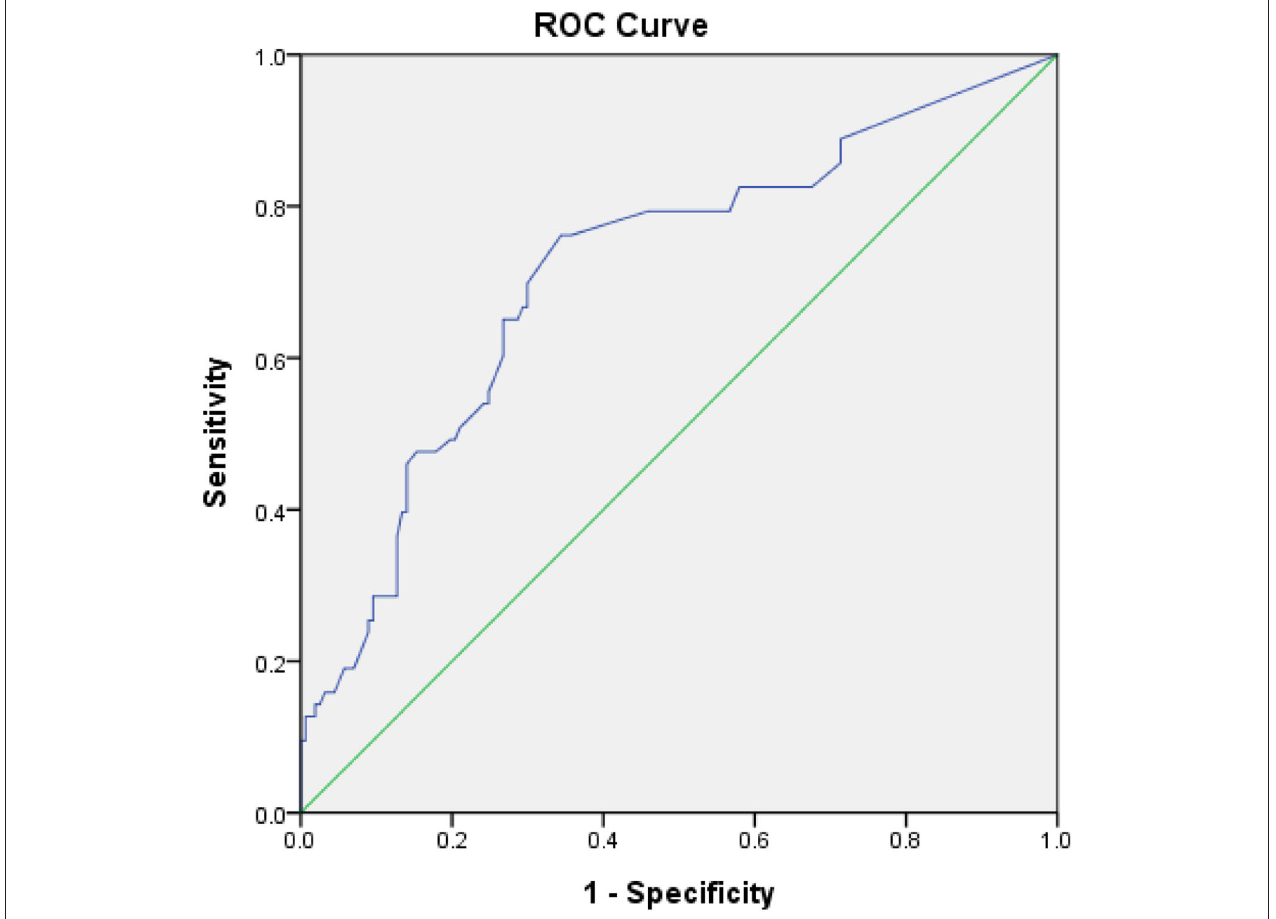
FIGURE 1 | Receiver-operating characteristic curve analysis of atrial high-rate episodes (min) in patients with CIEDs with subsequent systemic embolic events. Atrial high-rate episodes (min): optimal cutoff value with the highest Youden index, 3min; sensitivity, 76.2%; specificity, 70.0%; AUC, 0.716; 95% CI, 0.638–0.793; p <